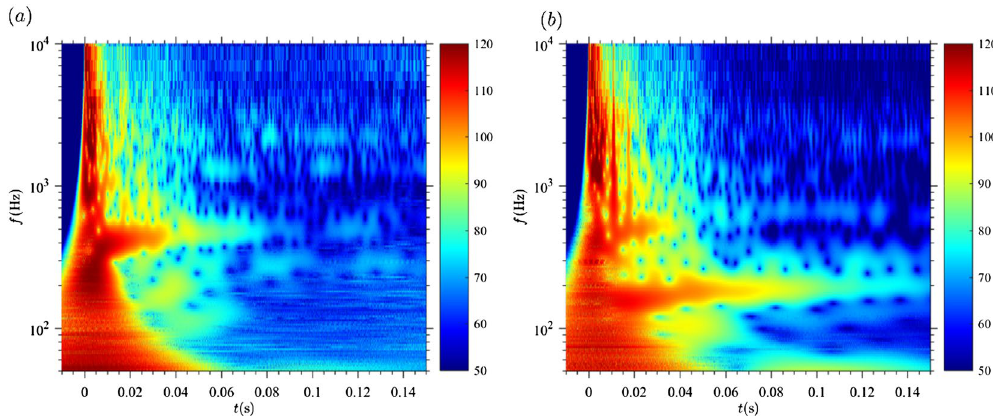
Figure 5. Effect of the non-dimensional mass supply on the acoustic signature of the shock-tube in the wavelet diagram. The color scale represents the sound pressure level [dB] at the microphone location. A e /A* = 1 and p 0r / p ∞ = 50. ( a ) L/D = 2. ( b ) L/D = 8.